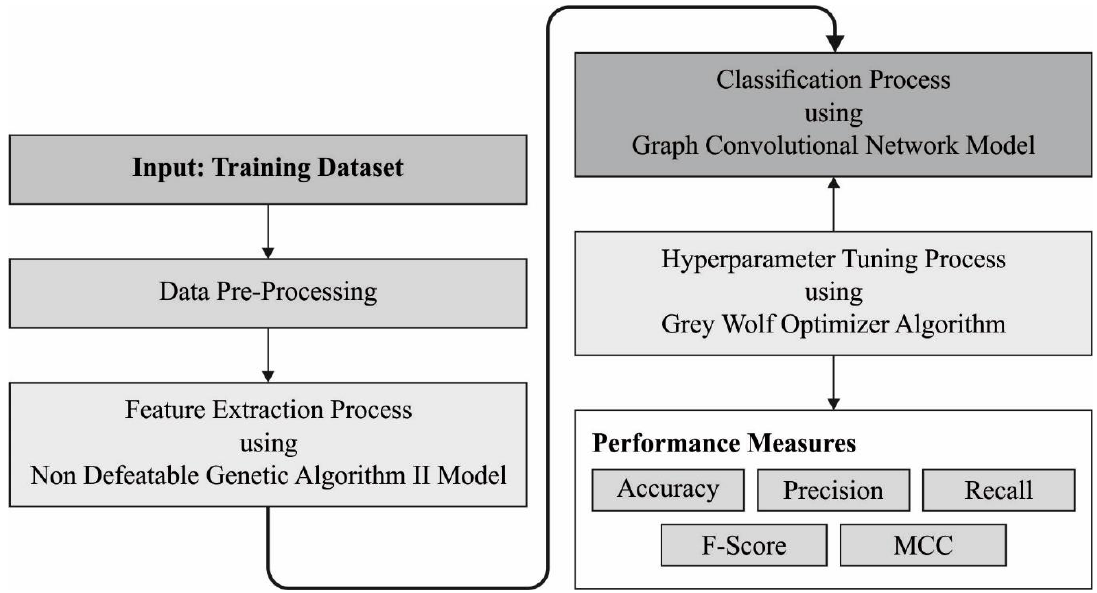
Figure 2. Working procedure of the MLMDMC-ED system.